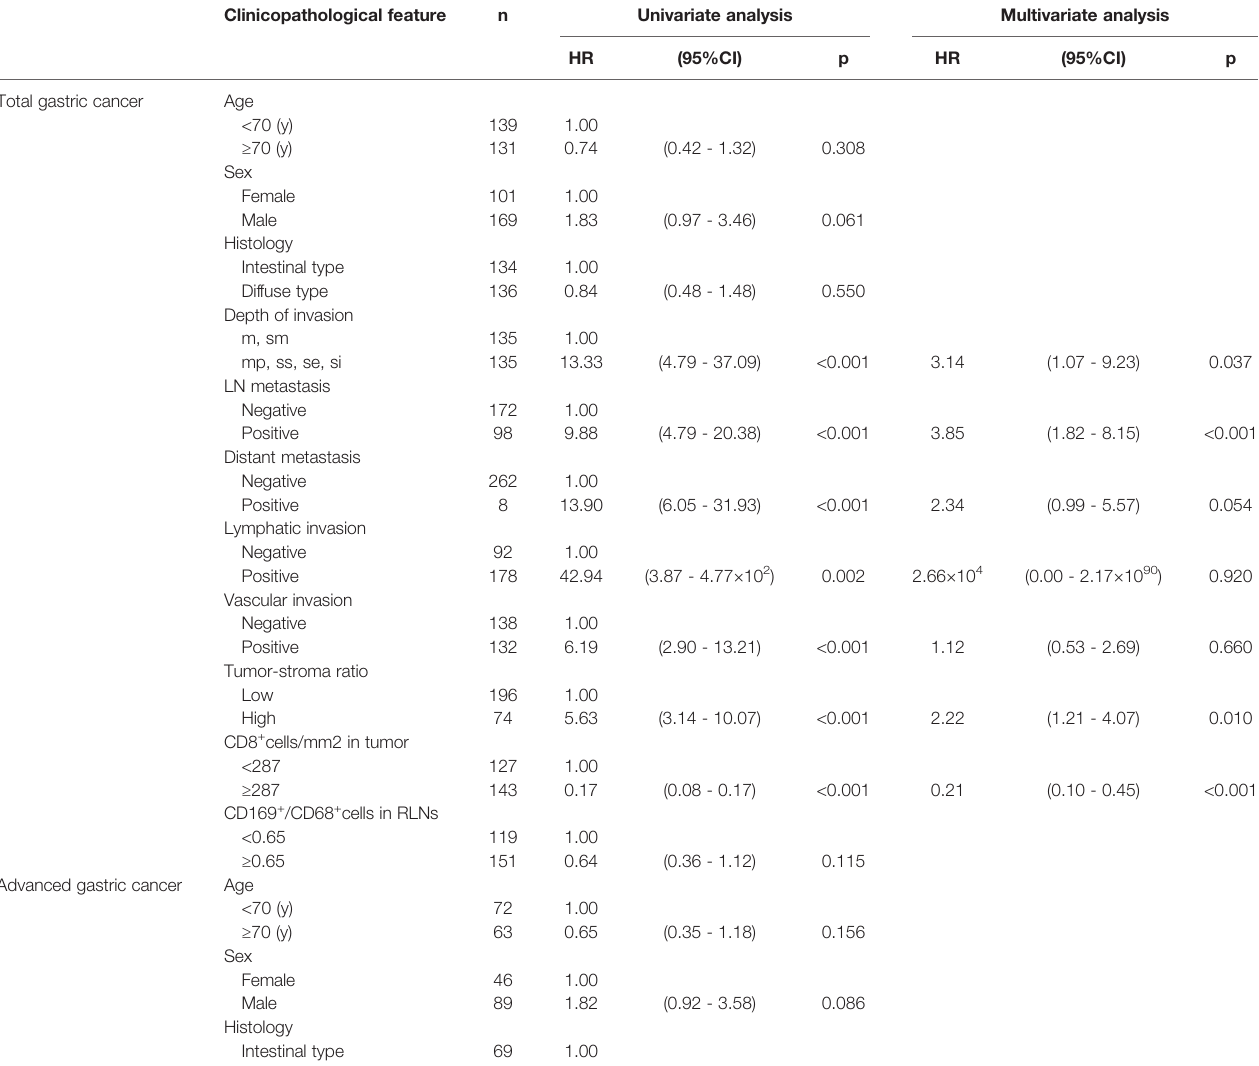
TABLE 3 | Univariate and multivariate Cox regression analysis of potential prognostic factors for relapse free survival in patients with total gastric cancer (n = 270) and advanced cancer (n = 135). Clinicopathological feature n Univariate analysis Multivariate